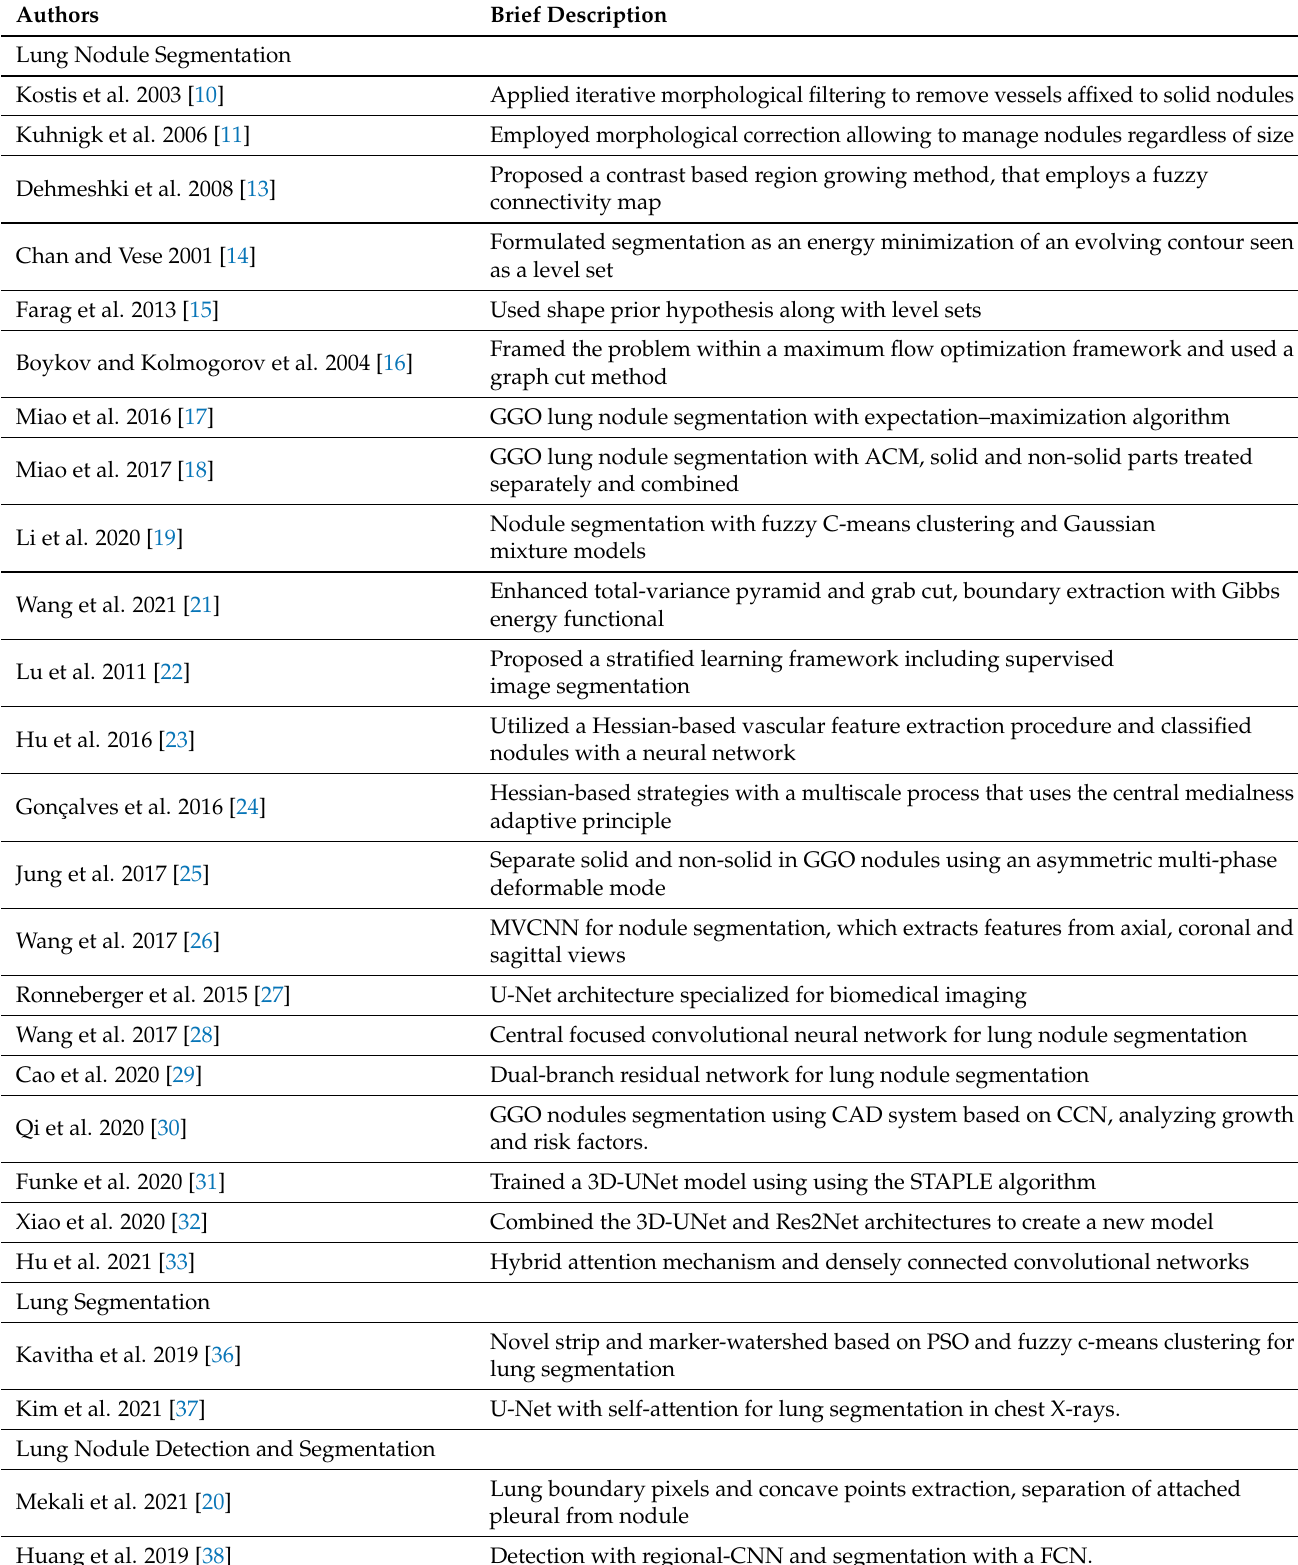
Table 1. A list of algorithms that are related to the proposed